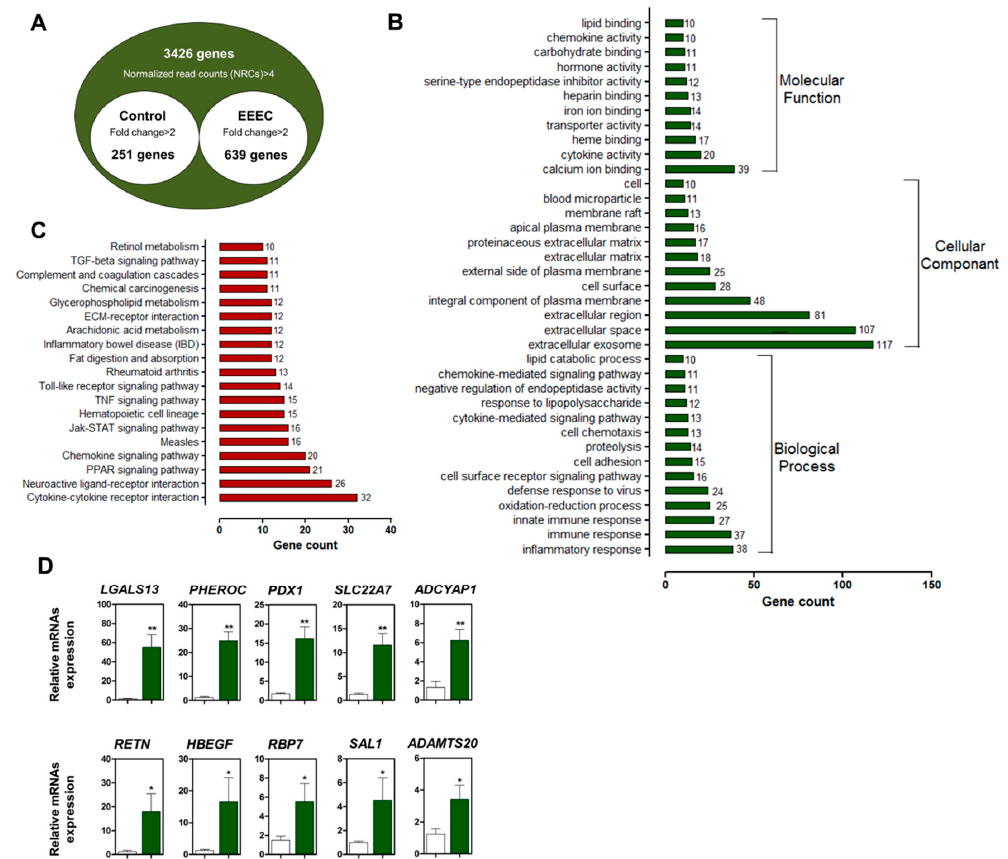
Figure 1. Gene expression profiling of the small intestine of pigs treated with the ethanol extract of dried E. cava (EEEC). ( A ) Venn diagram of genes up- or downregulated at least two-folds after EEEC treatment, compared with the control levels. ( B ) GO terms assigned to “biological processes”, “cellular components”, and “molecular functions” ( p < 0.01). ( C ) Kyoto Encyclopedia of Genes and Genomes (KEGG) pathway analysis of the same gene sets ( p < 0.01). ( D ) Quantitative analysis of the top 10 differentially expressed genes (DEGs; n = 3). Relative expression levels were normalized to those of glyceraldehyde 3-phosphate dehydrogenase ( GAPDH ). Error bars indicate standard error of triplicate analyses. * p < 0.05, ** p < 0.01.